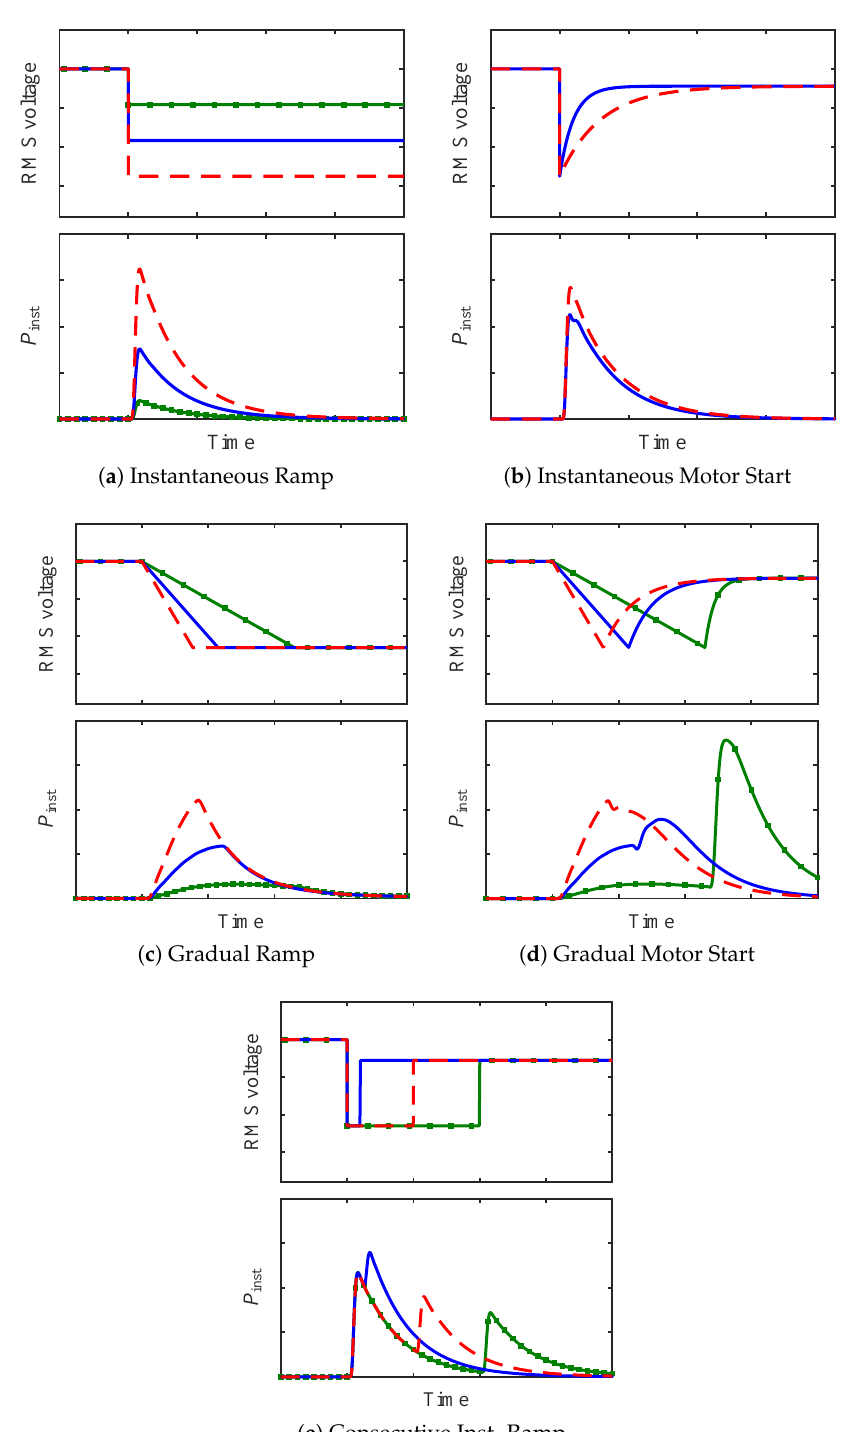
Figure 1. RVC types according to [28]: ( a ) instantaneous ramp; ( b ) instantaneous motor start; ( c ) gradual ramp; ( d ) gradual motor start; and ( e ) two consecutive instantaneous ramp RVCs. The top graphs show the RMS voltage, while the bottom graphs the P inst obtained with the IEC flickermeter. Each P inst curve in the bottom graphs is caused by the corresponding RMS curve in the top graph, identifiable by the same color and line-style (solid blue, dashed red, dotted